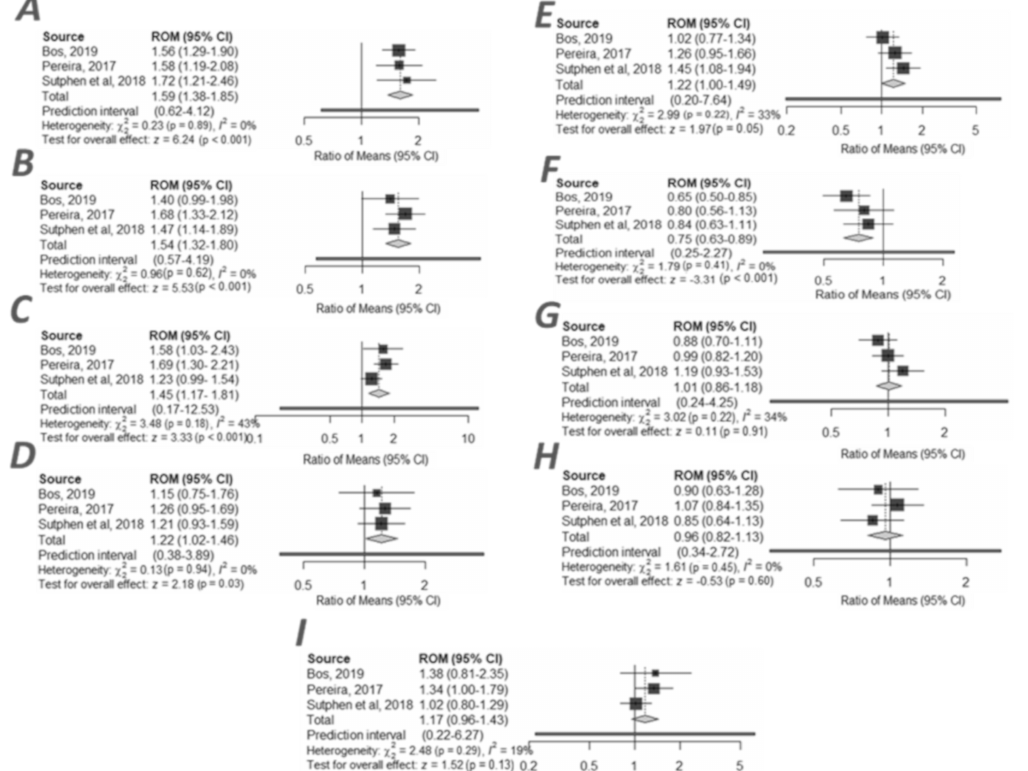
Figure 2. Forest plots of cerebrospinal fluid neurogranin ratio in compared groups according to amyloid beta status: ( A ) AD + vs. MCI- [13,18,25]; ( B ) AD + vs. CTRL- [13,18,25]; ( C ) MCI + vs. CTRL- [13,18,25]; ( D ) MCI + vs. CTRL + [13,18,25]; ( E ) AD + vs. CTRL + [13,18,25]; ( F ) MCI- vs. CTRL + [13,18,25]; ( G ) AD